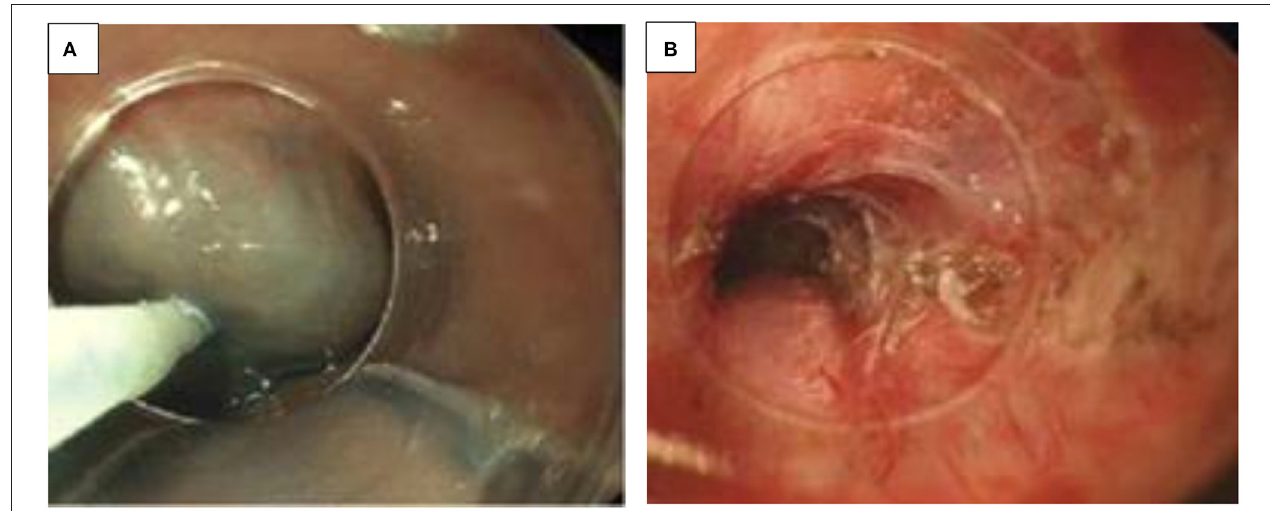
FIGURE 10 | (A,B) Peroral Endoscopic myotomy (POEM). (A) POEM procedure: Incision of the submucosal bleb to create a submucosal tunnel. (B) Myotomie during POEM procedure.